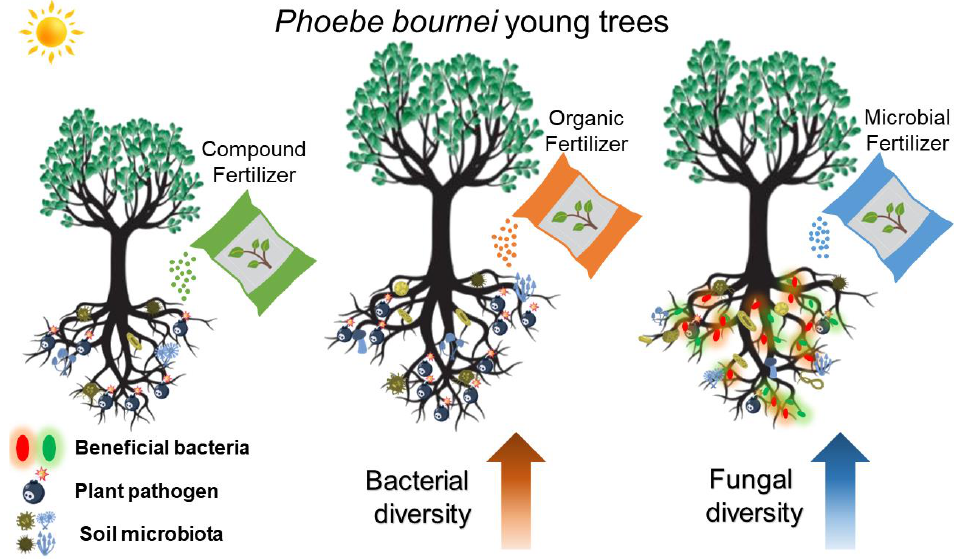
Figure 6. Conceptual diagram portraying the divergent strategy of rhizosphere bacteria and fungi under four typical fertilizer regimes.